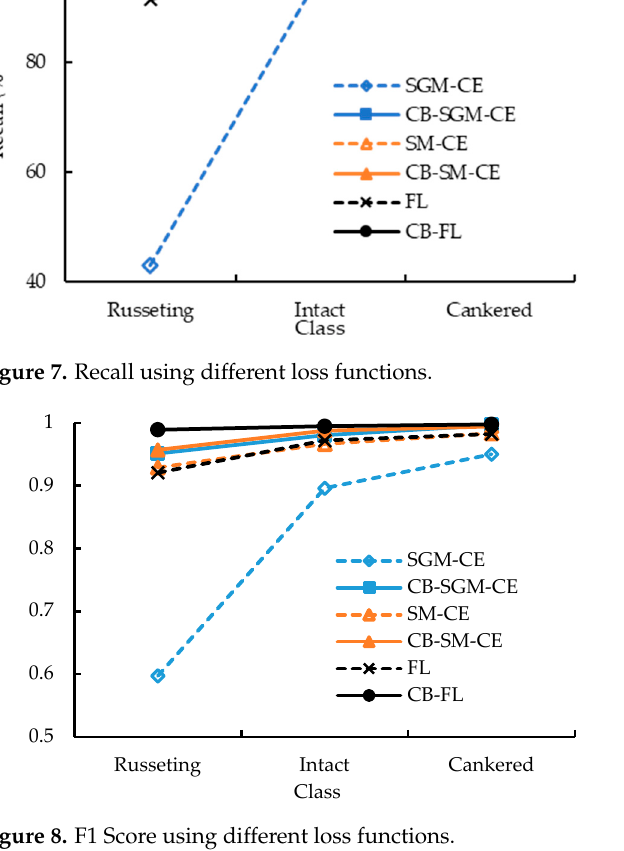
Figure 8. F1 Score using different loss functions.